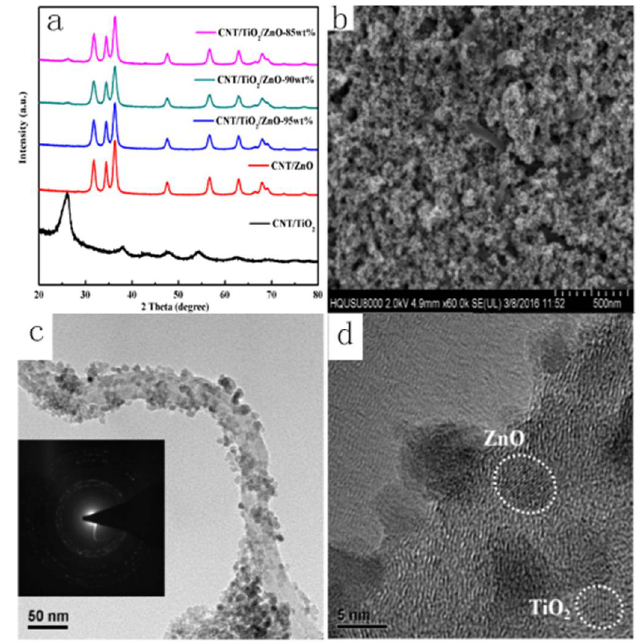
Figure 2. ( a ) X-ray powder diffraction (XRD) patterns of CNT/TiO 2 , CNT/ZnO, CNT/TiO 2 /ZnO-95 wt %, CNT/TiO 2 /ZnO-90 wt % and CNT/TiO 2 /ZnO-85 wt %; ( b ) SEM image of CNT/TiO 2 /ZnO-90 wt %; ( c ) Transmission electron microscopy (TEM) image with SAED pattern (inset) of CNT/TiO 2 /ZnO-90 wt %; ( d ) HRTEM image of CNT/TiO 2 /ZnO-90 wt %.